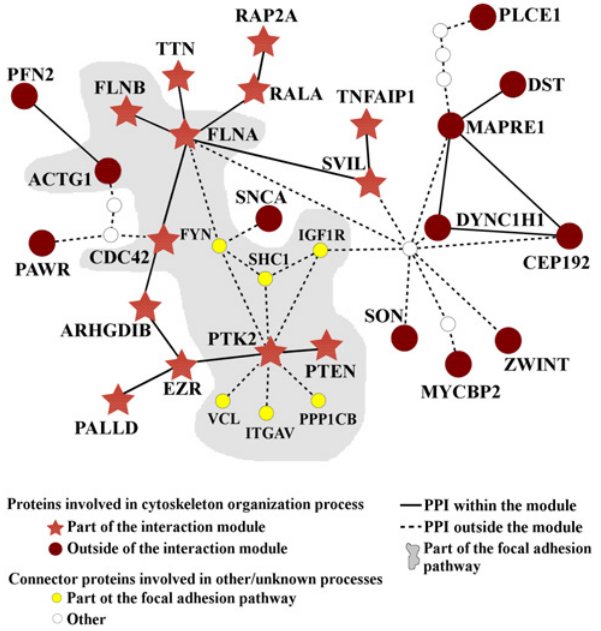
Fig 4. Actin cytoskeleton organization as a virulence factor target. Human proteins targeted by B. mallei proteins formed an interaction module that was primarily linked to cytoskeleton organization and focal adhesion. Twenty-five of these proteins were involved in cytoskeleton organization processes; 13 of them (red stars) interacted with each other (forming an interaction module), and the remaining 12 proteins (dark red circles) were on average < 2 nodes ( < 3 edges) away from the interaction module. The figure also shows the overlap between the cytoskeleton organization interaction module and the focal adhesion pathway (shaded area), where connecting protein interactions from focal adhesion pathway proteins or other proteins appear as smaller circles and dashed lines. Note that all human proteins shown interacted with one or more B. mallei